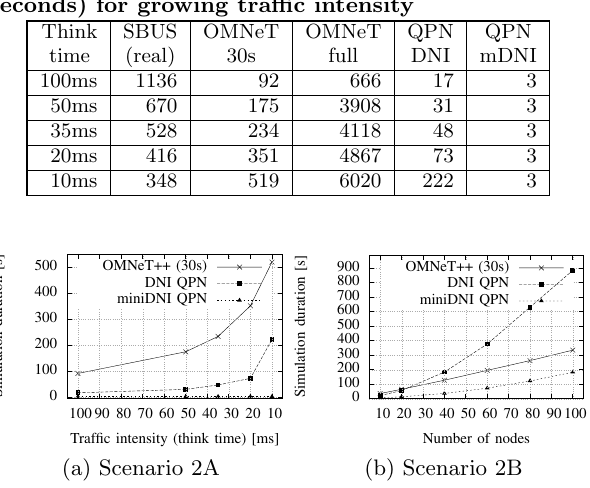
Figure 7: Scenarios 2 A and 2 B : model solution du- ration (in seconds) for growing traffic intensity (2A) and network size (2B)